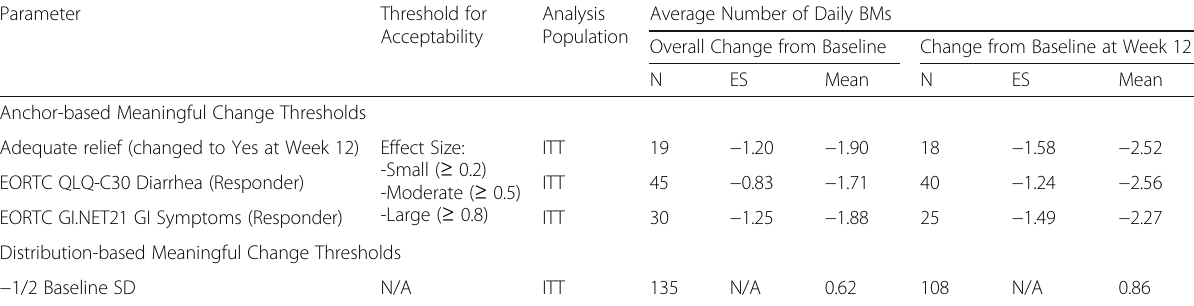
Table 1 Summary of Meaningful Change